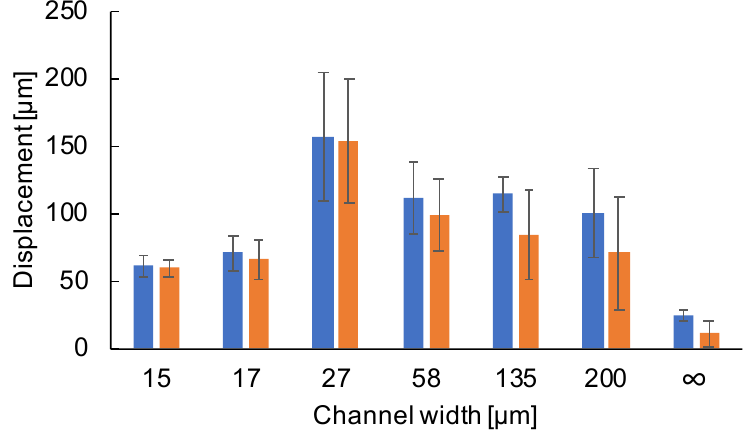
Figure 8. Evaluation of single cells’ total displacement distance and end-to-end distance in various microchannels. The tracking of single cells inside collective migration was computed to acquire the root-mean-square total displacement distance (blue bars) and the root-mean-square end-to-end distance (orange bars). In channel width axis, ∞ represents the tracking of isolated single cells in the free space without spatial constraints on the cultivation